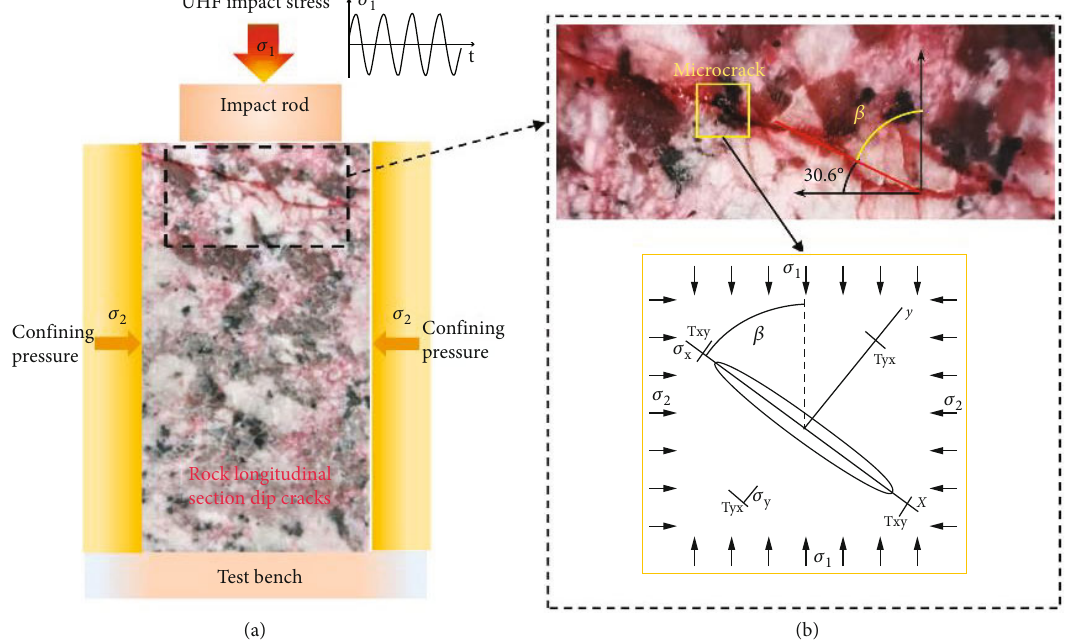
Figure 11: Microcrack extension angle model for granite after UHF impact: (a) microcrack dipping in longitudinal sections of granite; (b) microcrack extension angle and Gri ffi th crack extension